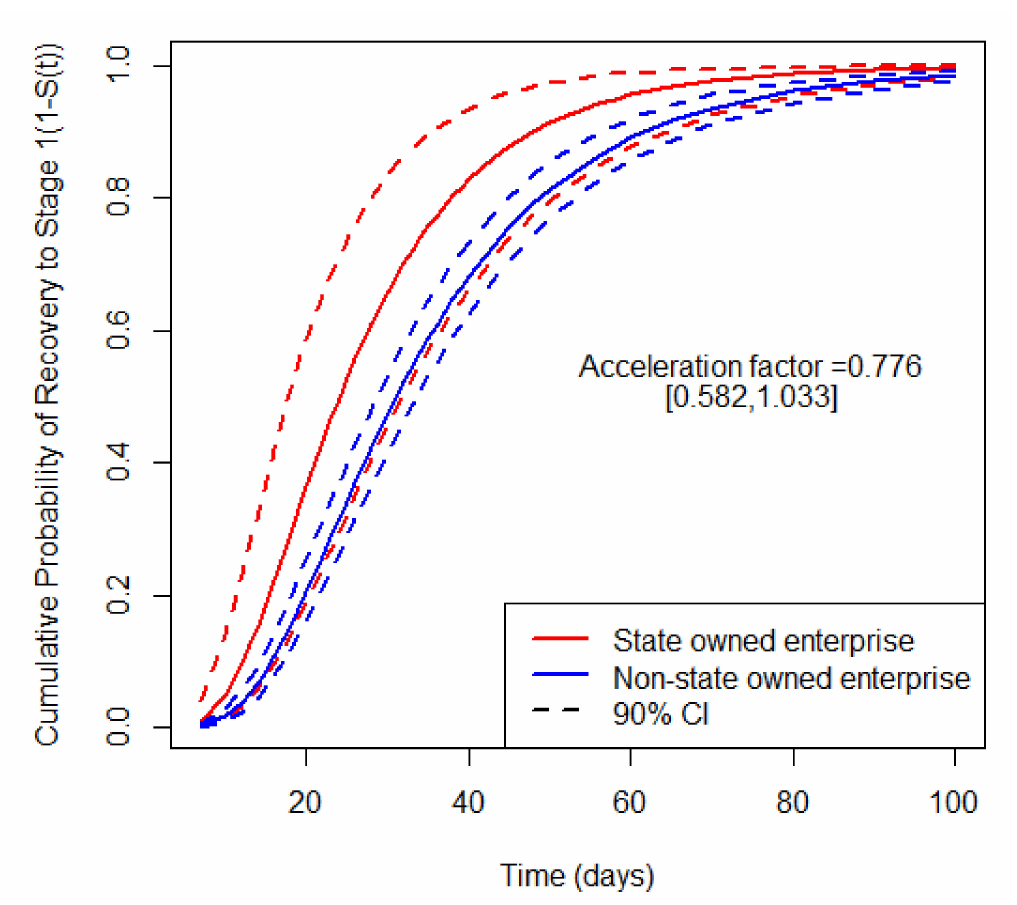
Figure 5. The enterprise ownership effect on the recovery probability curves of manufacturing